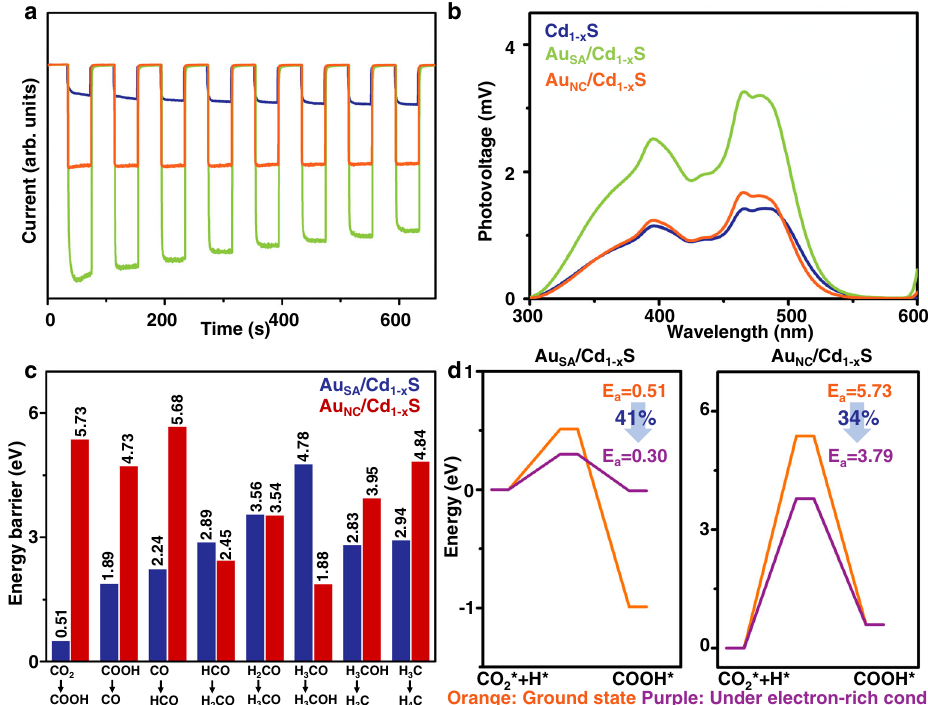
Fig. 7 Photo-induced carrier transfer and energy barriers in the process of CO 2 RR based on DFT calculations. a Transient photocurrent response and b SPV spectra of Cd 1-x S, Au SA /Cd 1-x S, and Au NC /Cd 1-x S samples. c Energy barriers of CO 2 reduction on Au SA /Cd 1-x S and Au NC /Cd 1-x S. d Reaction pro fi les of CO 2 transition into COOH on Au SA /Cd 1-x S and Au NC /Cd 1-x